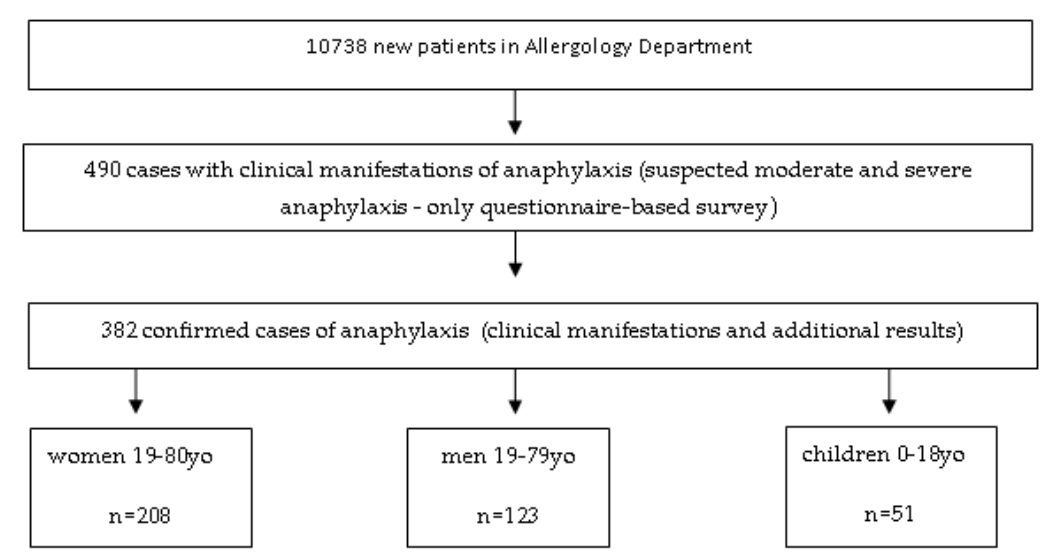
Figure 1. The structure of research and the division into groups.